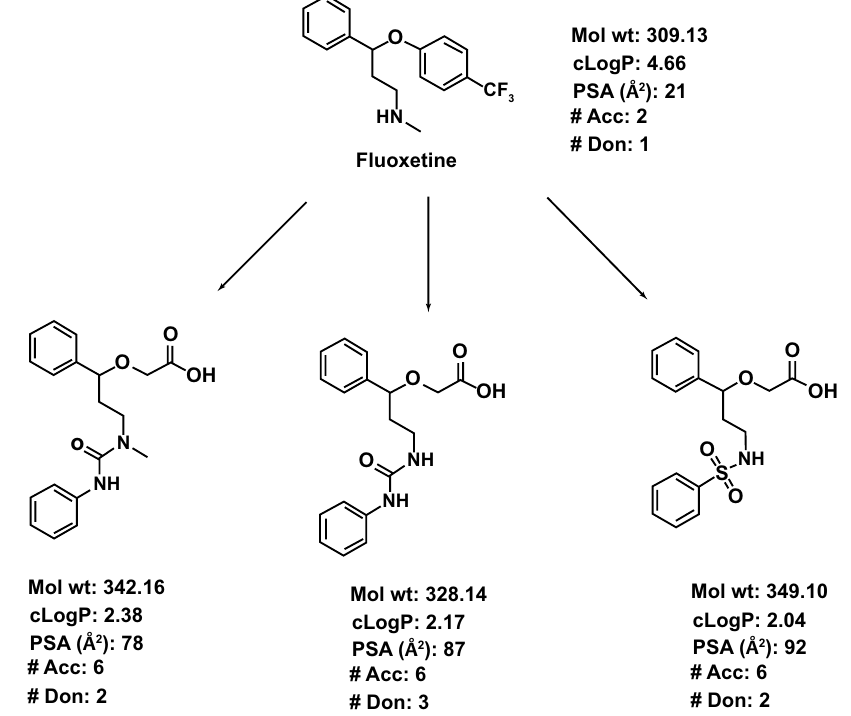
Figure 1. A theoretical illustration of the concept of using CNS drugs for non-CNS targets. Fluoxetine, an antidepressant agent, is used as a template. The synthesis of the analogs can be achieved by modifying the synthetic route of fluoxetine itself. The major structural modification includes abolishing the basicity of the secondary N in fluoxetine by converting it to urea or sulfonamide. Similarly, the 4-CF ring is replaced with an acetic acid side chain. The resultant structural modifications lead to increased PSA, decreased cLogP (calculated LogP) and an increased number of H-bond donors and